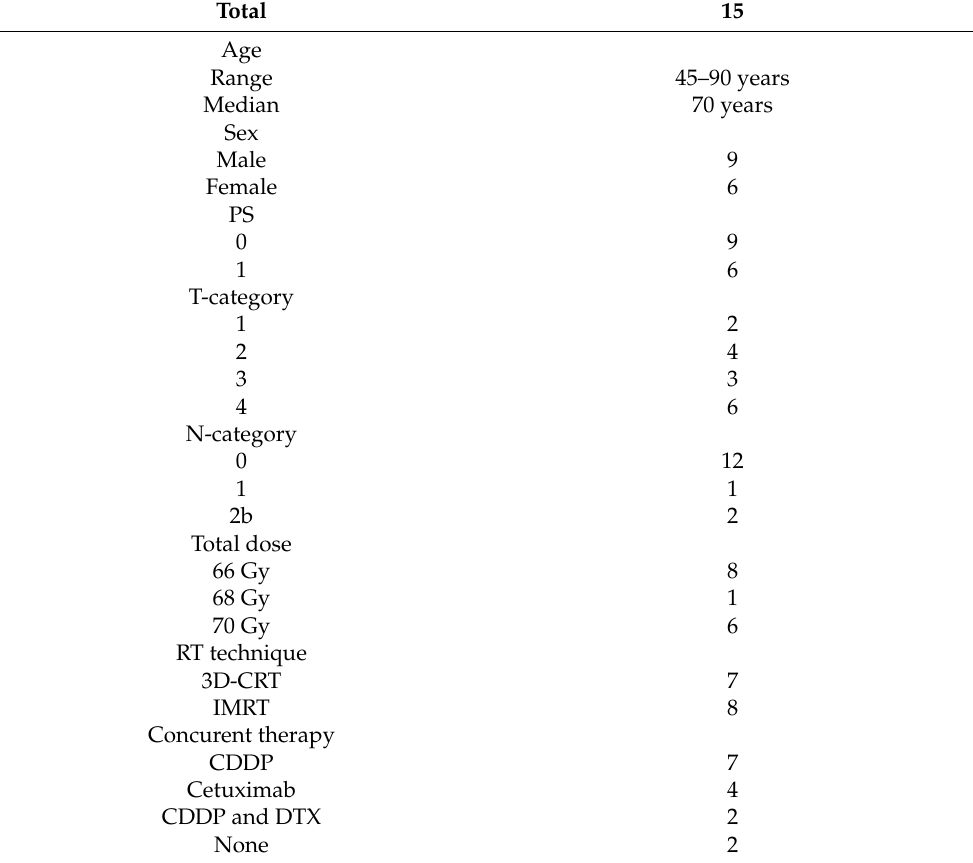
Table 1. Characteristics of the patients and their